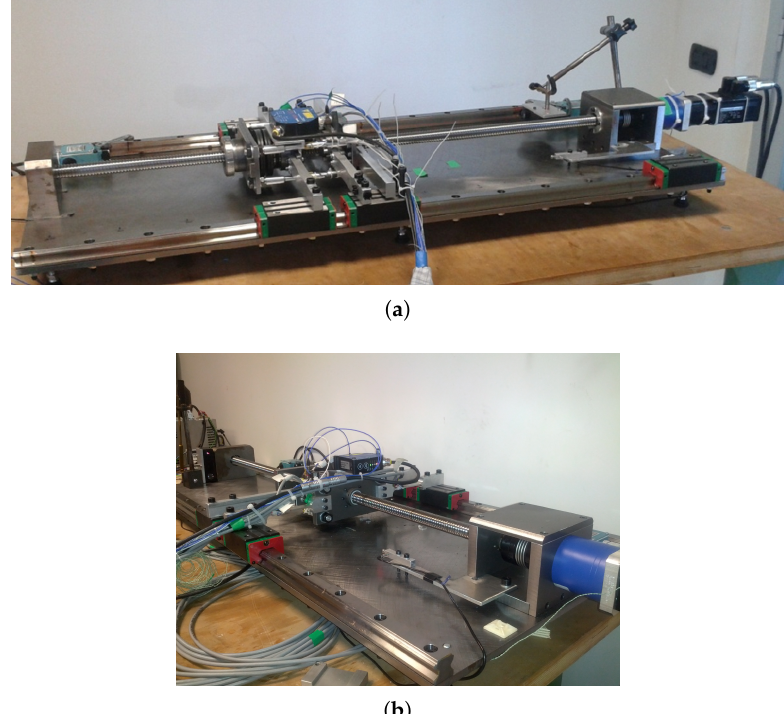
Figure 7. Test bench prototype. ( a ) Side view. ( b ) Back wiev.